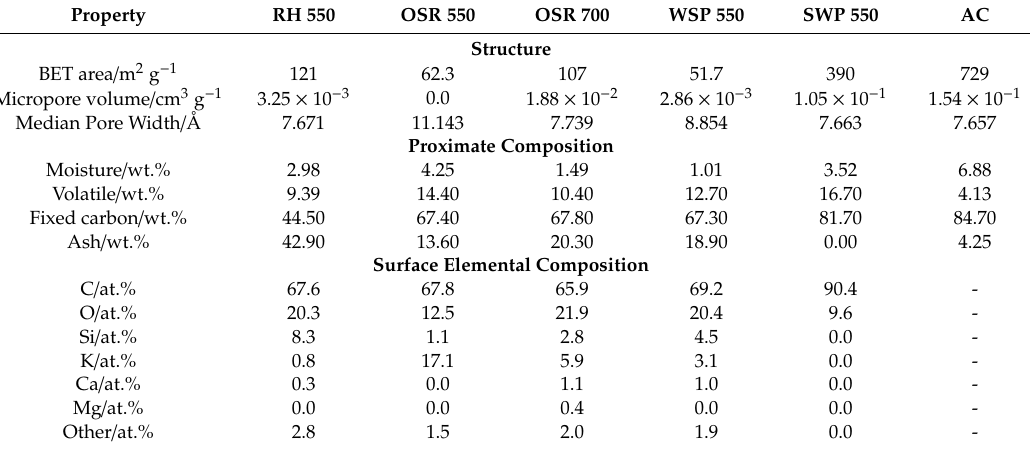
Table 2. Summary of the characterisation of biochars from di ff erent feedstocks (rice husk (RH), oil seed rape (OSR), wheat straw (WSP) and soft wood (SWP)) and compared with a commercial activated carbon (AC). A dash indicates that experimental data is not available. Results for elemental composition reported to one decimal place.